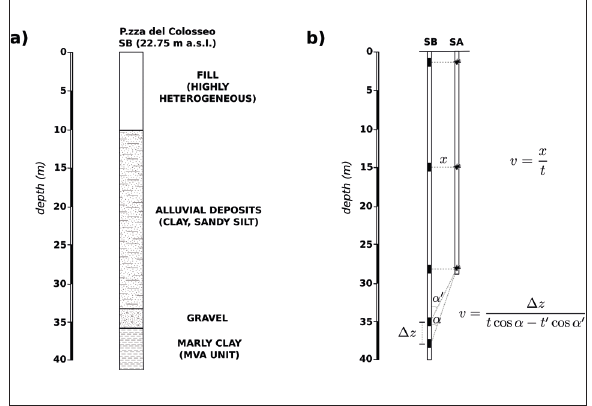
Figure 3. Borehole seismic at the Colosseum. (a) Simplified strati- graphic column of the SB borehole. (b) acquisition geometry of the borehole seismic